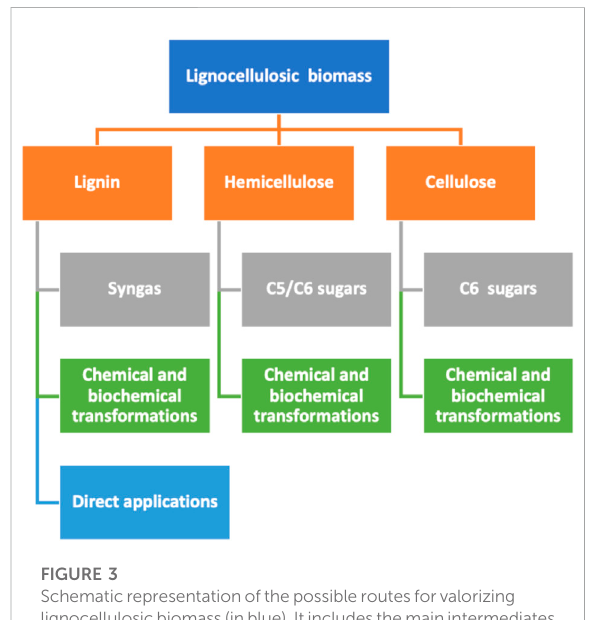
FIGURE 3 Schematicrepresentationofthepossibleroutesforvalorizing lignocellulosicbiomass(inblue).Itincludesthemainintermediates (in orange) to produce valuable products (in gray) or being directly applied (in light